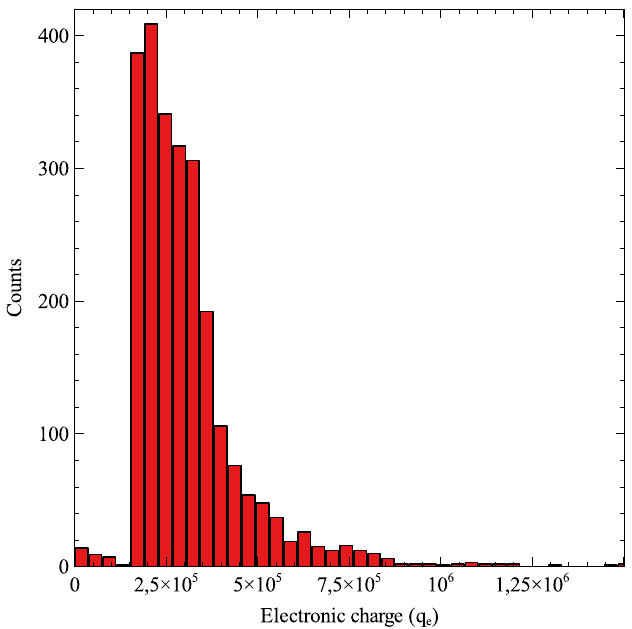
Fig. 13. Electronic induced charges histogram of a CFUR estimated with 2.5 × 10 3 pulses.